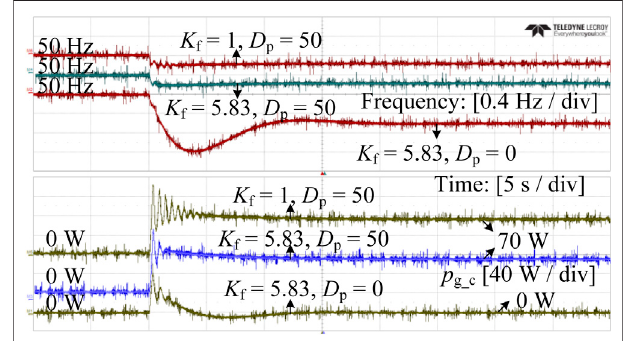
FIGURE14| Experimentalfrequencyandactivepowerresponsesunder a 100 W step-up load change.